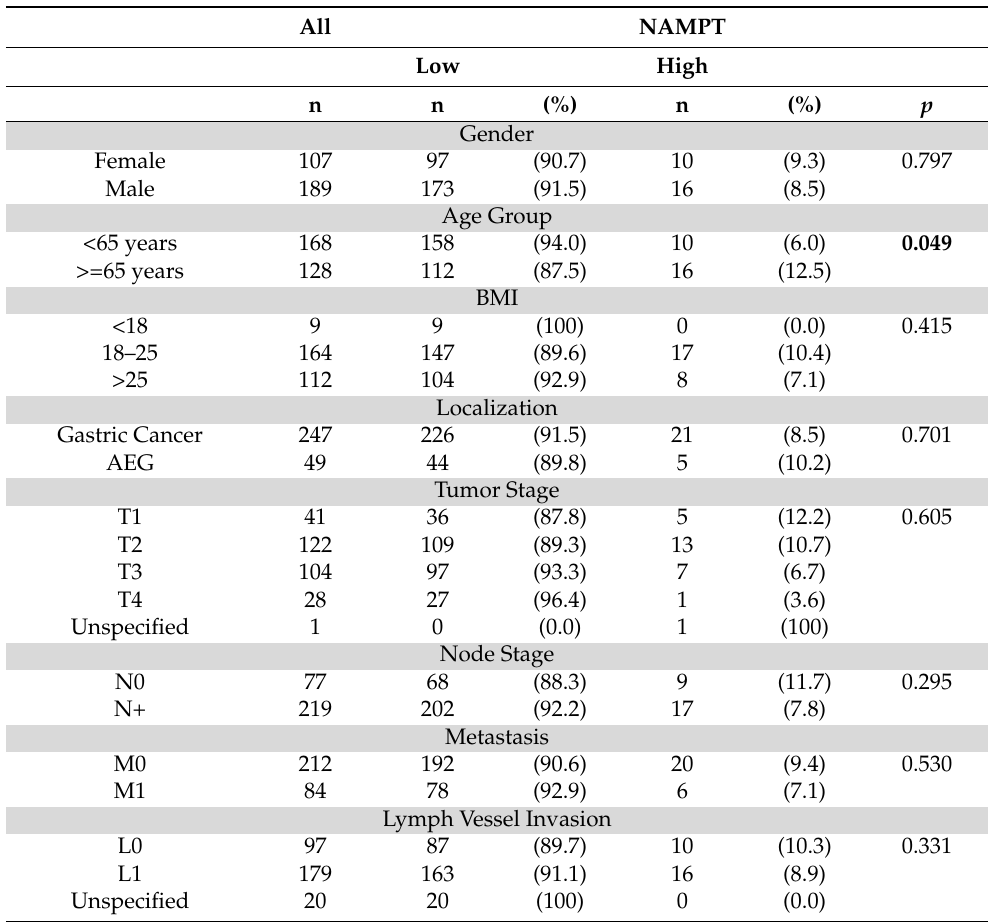
Table 1. Patient characteristics of the analyzed patient cohort (combined TNM classification of AEG and gastric carcinoma) and distribution of NAMPT high and low expressing primary tumors. Significance calculated by